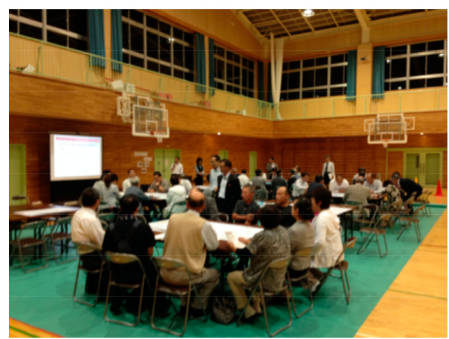
Figure 12. Tsunami evacuation workshop in